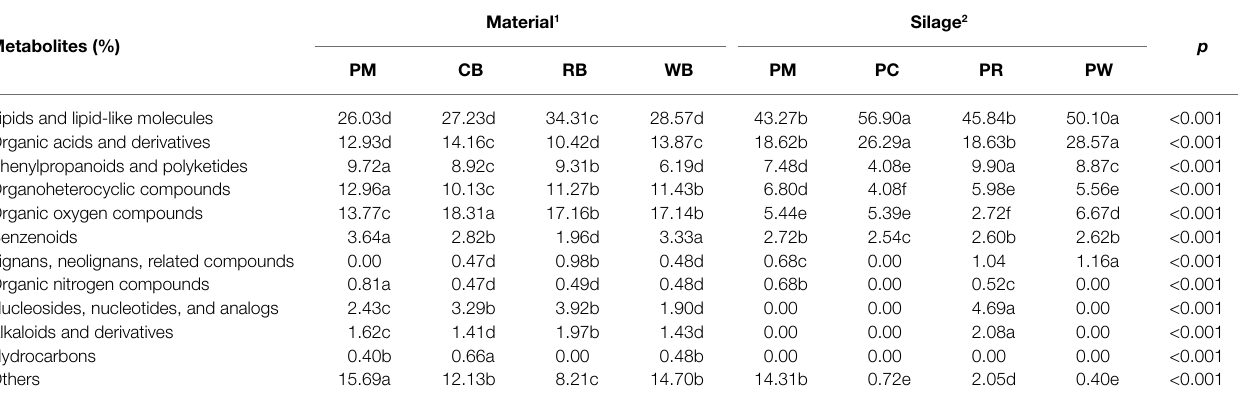
TABLE 3 | The HMDB compound classification based on the number of metabolites at the level of superclass of PM, CB, RB, WB material, and their silage. Material 1 Silage 2 Metabolites (%)